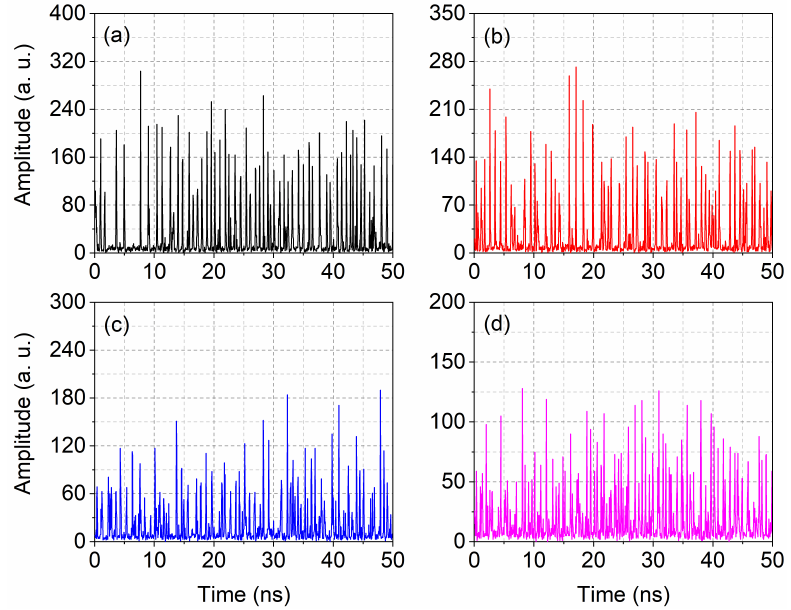
Figure 4. Sample of temporal dynamics obtained under the following conditions: P = 1.6 P th , η = 0.005, (cid:104) L T (cid:105) ≈ 27.1 ( a ); P = 1.5 P th , η = 0.01, (cid:104) L T (cid:105) ≈ 24.1 ( b ); P = 1.3 P th , η = 0.05, (cid:104) L T (cid:105) ≈ 19.4 ( c ); P = 1.15 P th , η = 0.1, (cid:104) L T (cid:105) ≈ 16.4 ( d